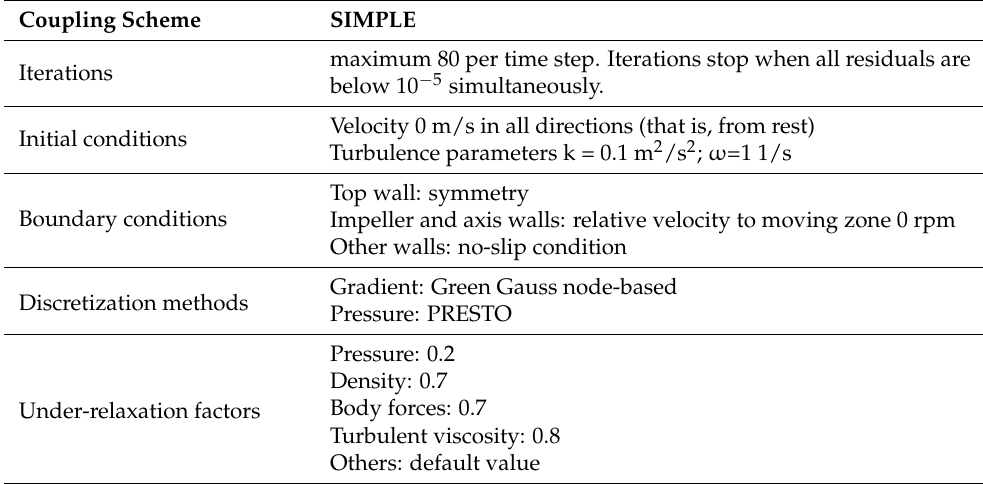
Figure 3. Flow diagram of the configuration used to model the abiotic systems with Xanthan Sol A and Xanthan Sol B, using the ( a ) SST k-omega turbulence model and ( b ) k-kl-omega transition model (IC: initial condition). Table 2. Settings shared by the CFD models of Xanthan Sol A and Xanthan Sol B.